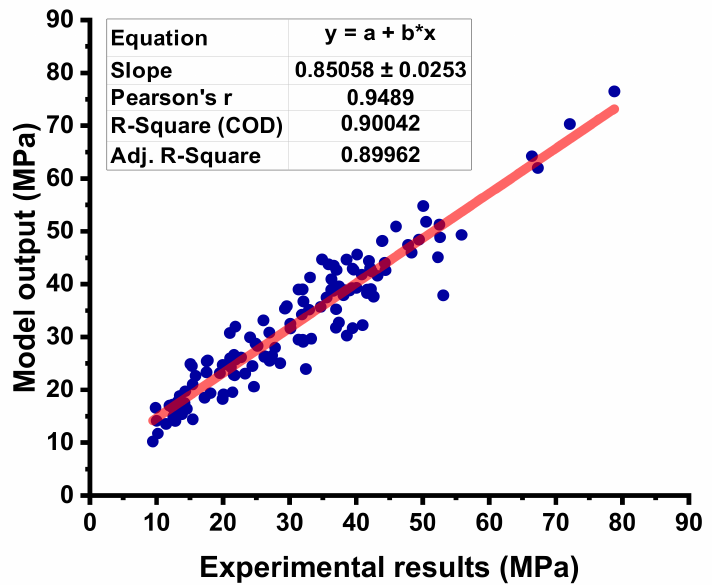
Figure 9. Correlation between the experimental C-S and the estimated C-S for the MLP